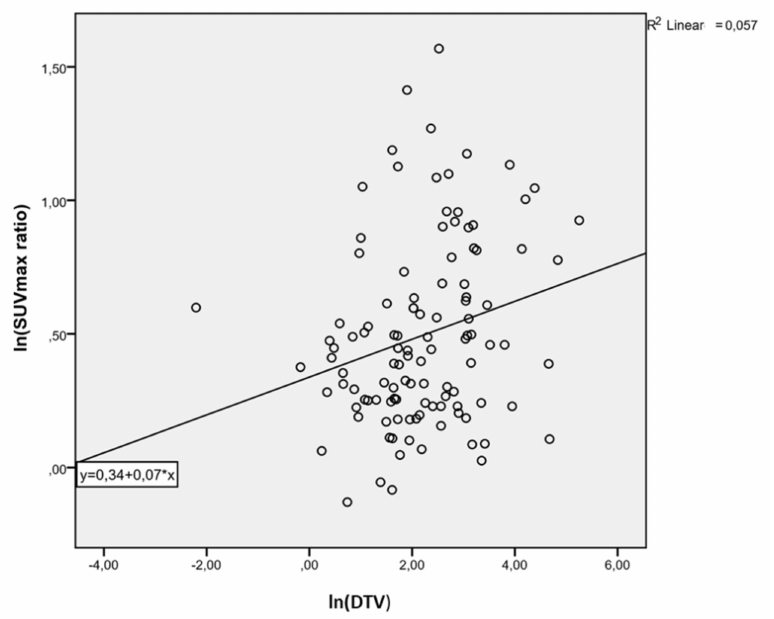
Figure 4. Univariate analysis model of the association between lnSUVmax ratio and